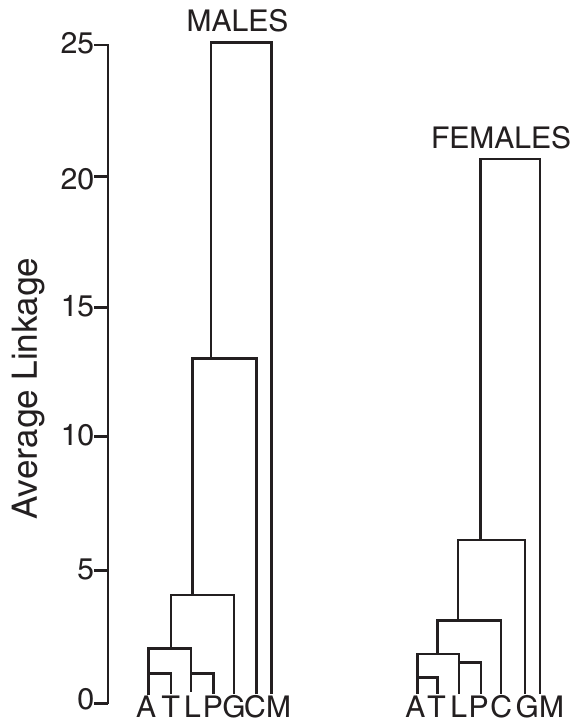
F IG . 1. – Cluster analysis using the Average Linkage method for the examination of the distances between the mean lengths ( CL ) of the monthly samples of the various areas for each sex. Faro in the Atlantic (P), the Alboran Sea off Malaga (M), the Catalan Sea off Barcelona (C), the Ligurian Sea off Genoa (L), the Tyrrhenian Sea off P.S. Stefano (T), the Adriatic Sea off Ancona (A) and the